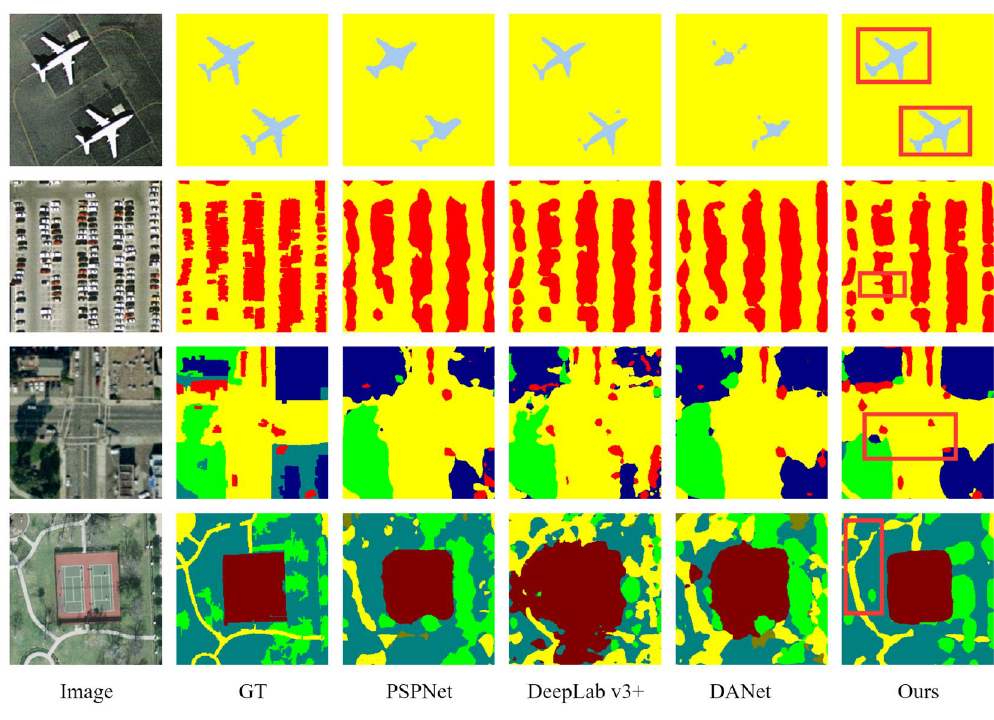
Figure 5. DLRSD (val) dataset visualization